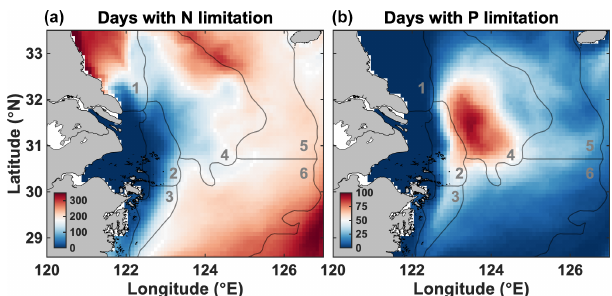
Figure 4. Annual duration in days of N (a) and P (b) limitation in surface waters. The grey contours indicate the limits of the six zones (see Fig. 1).